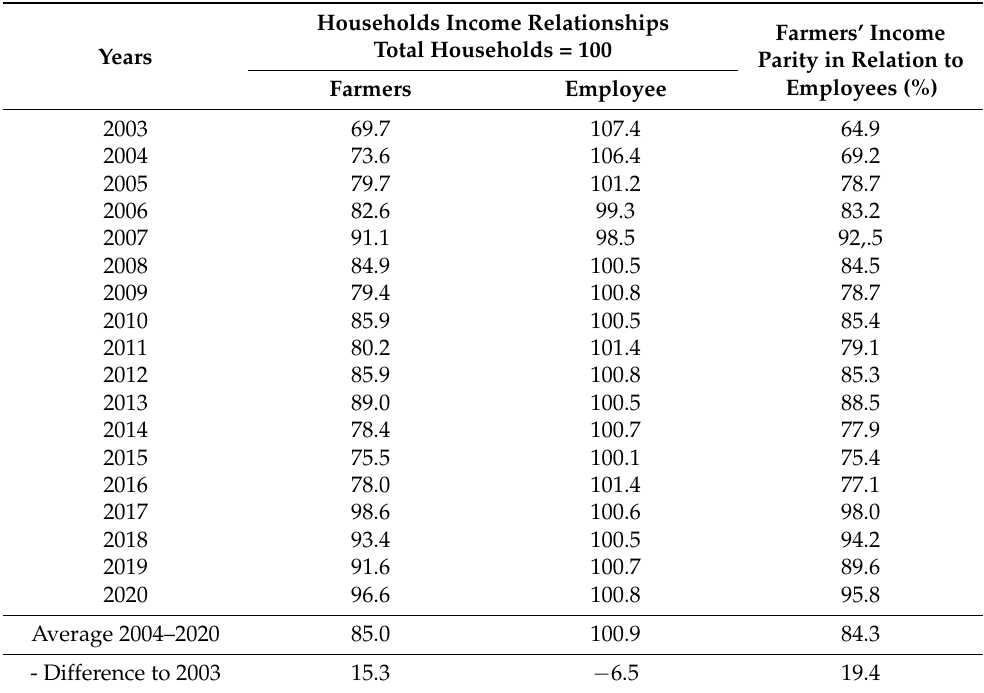
Table 1. Relationships of available income per capita of farmers ‘and employees’ households in relation to total household income (in %). Households Income Relationships Total Households = 100 Years